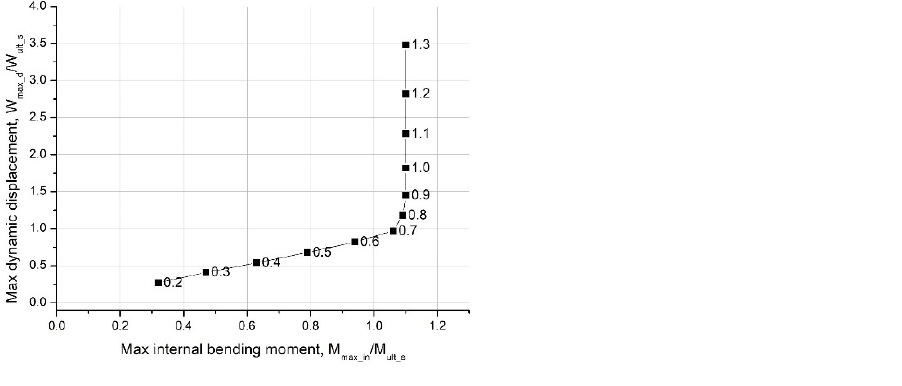
Table 3. Dynamic ultimate strength of the box girder.